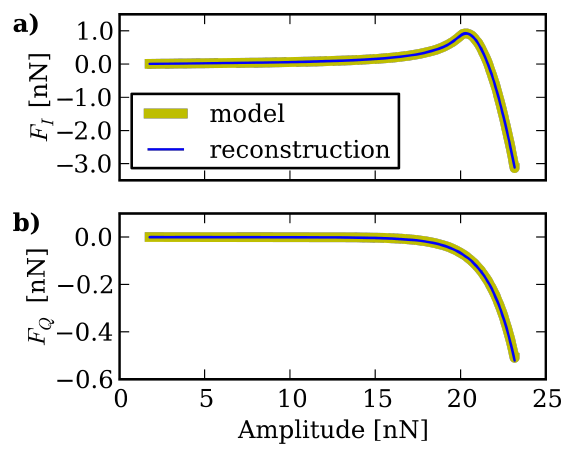
Figure 5: The F I ( A ) and F Q ( A ) curves reconstructed from simulated tip motion in ImAFM. The reconstructed curves are in good agreement with the actual curves directly determined from the model force used in the simulations.